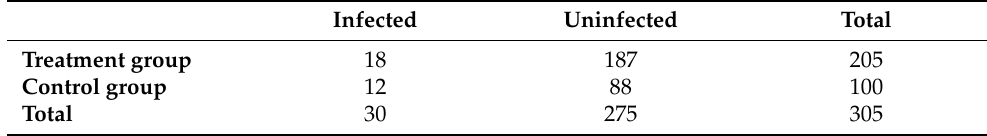
Table 4. Sample Data for Calculation Odds Ratio [53].